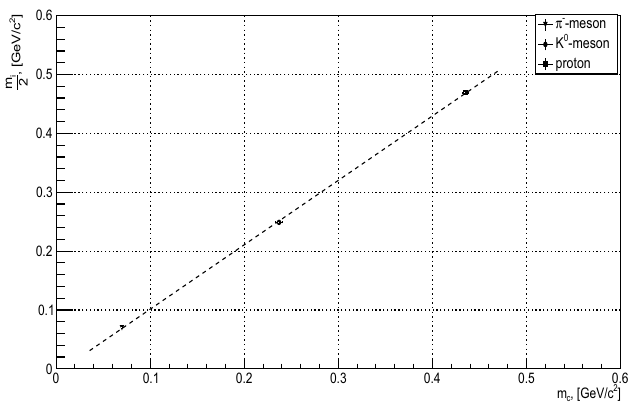
Figure 6. m i vs target mass m c = m p · < n c > calculated under the condition that m i / 2 = m c 2